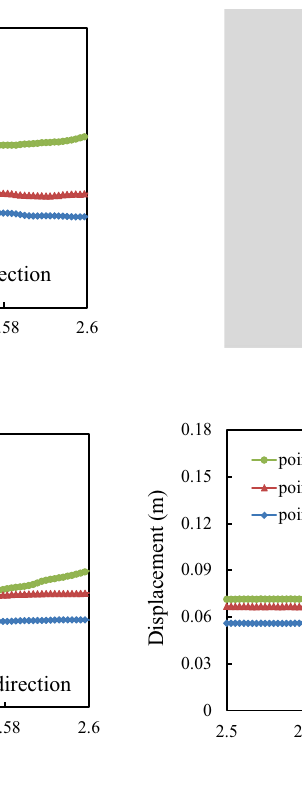
direction indicates the horizontal direction, xy direction indicates both vertical and horizontal